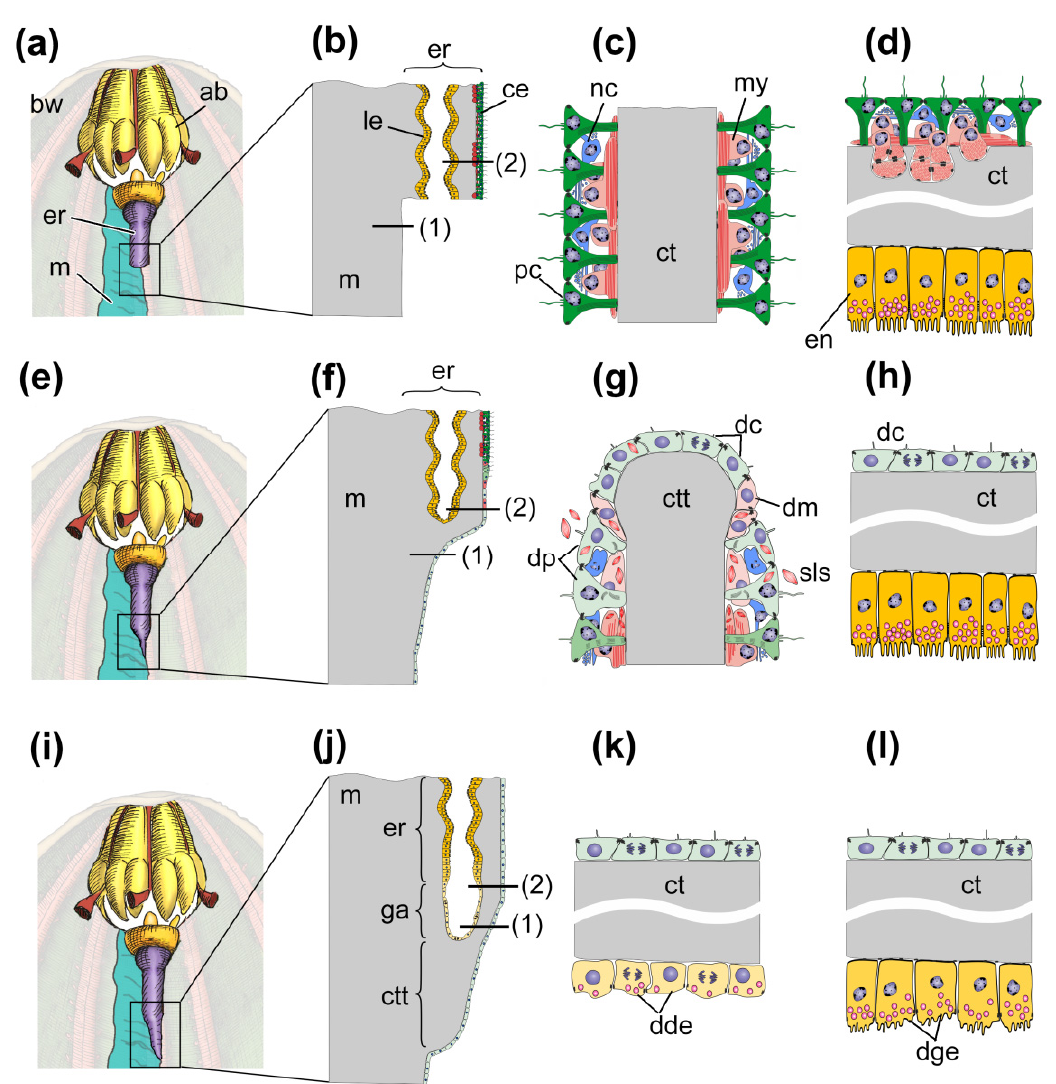
Figure 2. Scheme of regeneration of anterior part of digestive system after posterior evisceration. ( a ) Anterior part of holothurian just after evisceration; ( b ) Longitudinal section of the region of the esophagus remnant and mesentery, which is marked by the rectangle in ( a ). ( c ) Transverse section of the region of mesentery which is marked by solid line (1) in ( b ). ( d ) Transverse section of the region of esophagus remnant which is marked by solid line (2) in ( b ). ( e ) Anterior part of holothurian on third day post-evisceration; ( f ) Longitudinal section of the region of the esophagus remnant and connective tissue thickening, which is marked by the rectangle in ( e ). ( g ) Transverse section of the region of connective tissue thickening which is marked by solid line (1) in ( f ). ( h ) Transverse section of the region of esophagus remnant which is marked by solid line (2) in ( f ). ( i ) Anterior part of holothurian on seventh day post-evisceration; ( j ) Longitudinal section of the region of gut anlage, which is marked by the rectangle in ( i ). ( k ) Transverse section of the region of growing end of anterior gut anlage which is marked by solid line (1) in ( j ). ( l ) Transverse section of the region of growing end of anterior gut anlage which is marked by solid line (2) in ( j ). ab, aquapharyngeal bulb; bw, body wall; ce, coelomic epithelium; ct, connective tissue; ctt, connective tissue thickening; dc, de-differentiated coelomic epithelial cell; dde, de-differentiated enterocyte; dge, de-differentiating enterocyte; dm, de-differentiating myoepithelial cell; dp, de-differentiating peritoneal cell; en, enterocyte; er, esophagus remnant; ga, anterior gut anlage; le, luminal epithelium; m, mesentery; my, myoepithelial cell; nc, nerve cell; pc, peritoneal cell; sls, myofilaments grouped in spindle-like structures. Thus, according to morphological data, the main regeneration processes in holothuri- ans after posterior evisceration are dedifferentiation, cell proliferation, ECM remodeling, and epithelial morphogenesis. In H. glaberrima , some cells of coelomic epithelium